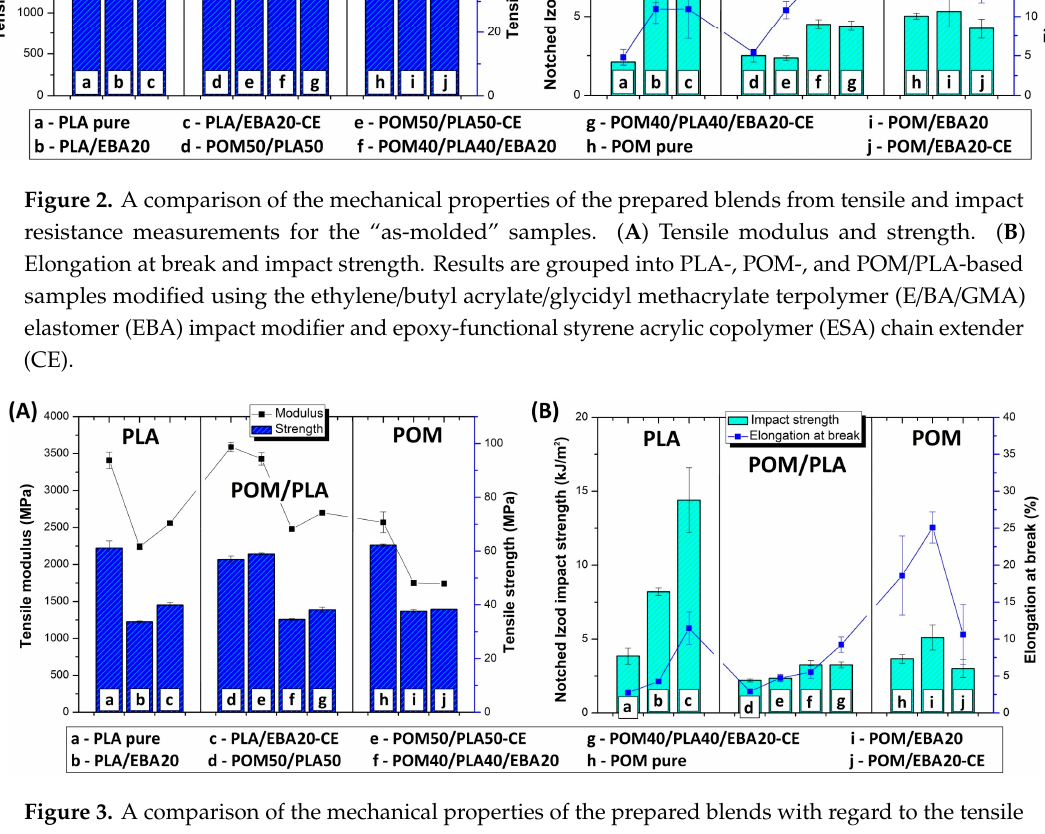
Figure 3. A comparison of the mechanical properties of the prepared blends with regard to the tensile and impact resistance measurements for the “annealed” samples. ( A ) Tensile modulus and strength. ( B ) Elongation at break and impact strength. Results are grouped into PLA-, POM-, and POM/PLA-based samples modified using the E/BA/GMA impact modifier and ESA chain extender.